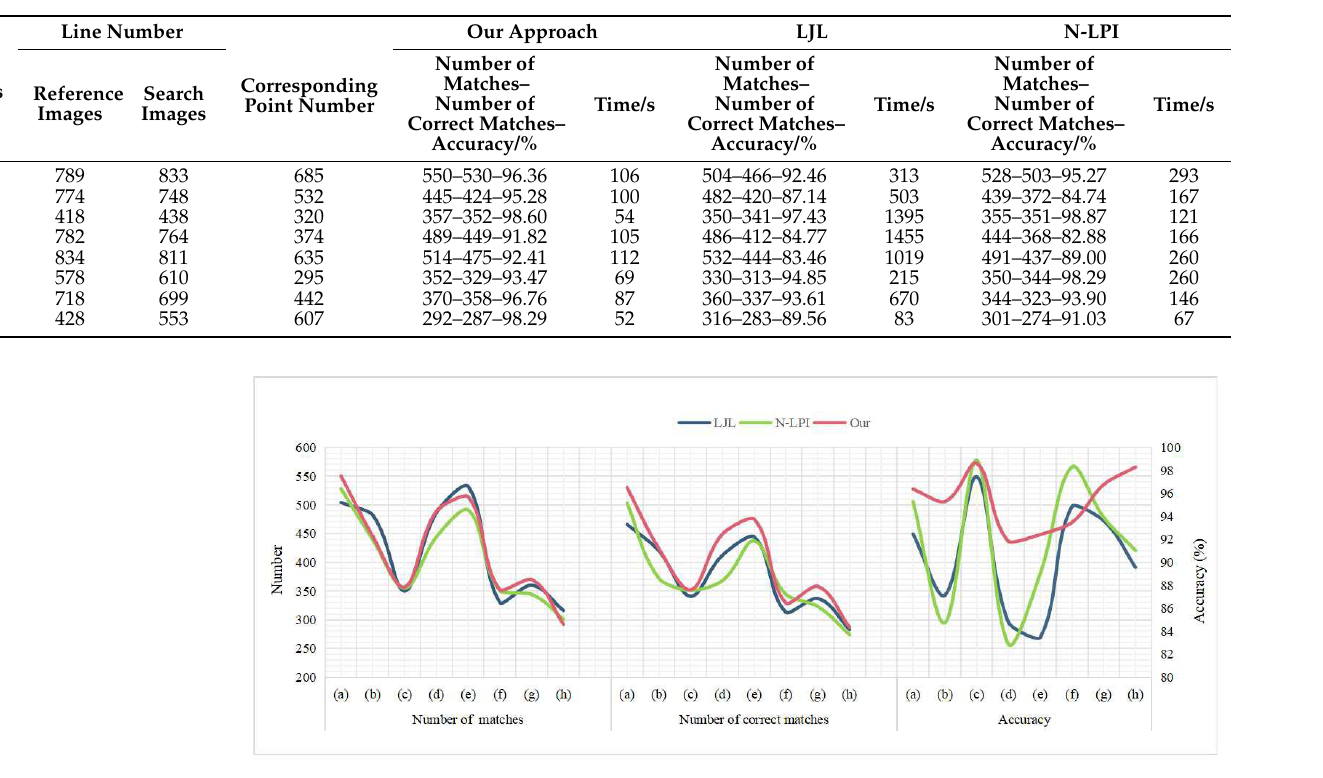
Figure 12. Number of matches, number of correct matches and accuracy obtained by three approaches for 8 image pairs. ( a – h ) are Figure 7a–h image pairs.